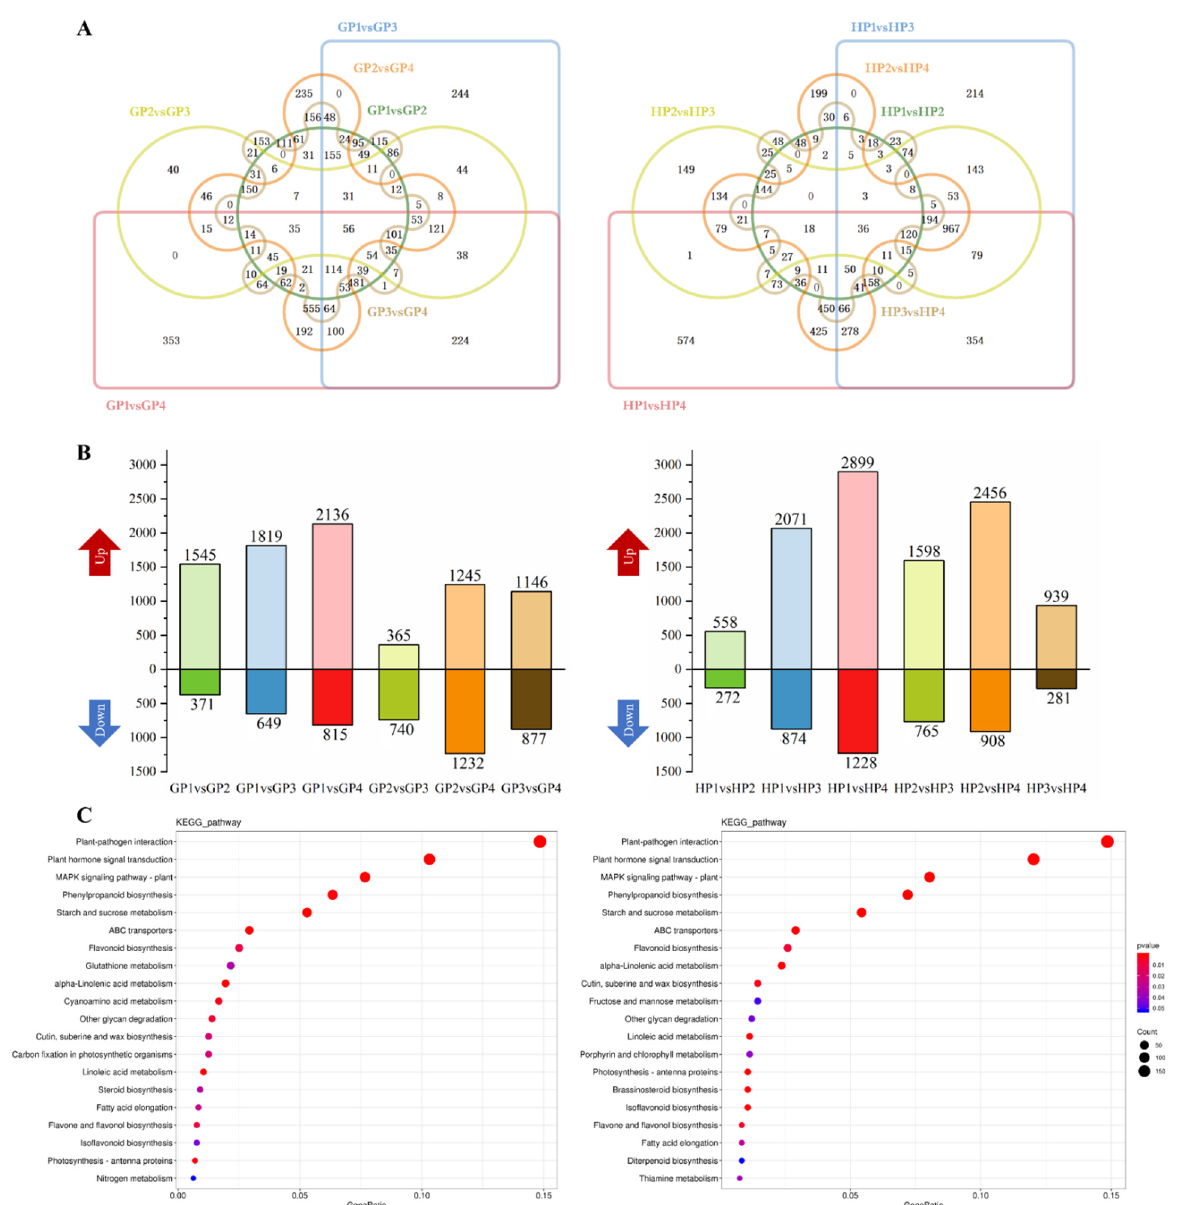
Figure 1. The transcriptomic results of young pomelo fruits. ( A ) Venn plot of six comparing groups in two varieties of young pomelo fruits. ( B ) The up- and down-regulated DEGs in two varieties of young pomelo fruits (FC > 2, p < 0.01). ( C ) KEGG enrichments of DEGs in two varieties of young pomelo fruits.